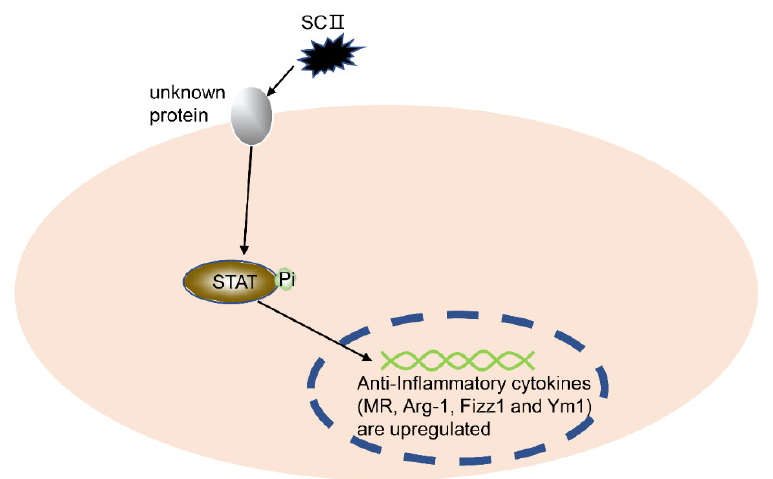
Figure 4. SCII regulates the polarization of macrophages. After SCII treatment of macrophages, the phosphorylation level of STAT6 was significantly increased, and the transfer of p-STAT into the nucleus was promoted. Finally, the macrophages were polarized to M2. SCII, squid type II collagen; STAT6, signal transducer and activator of transcription